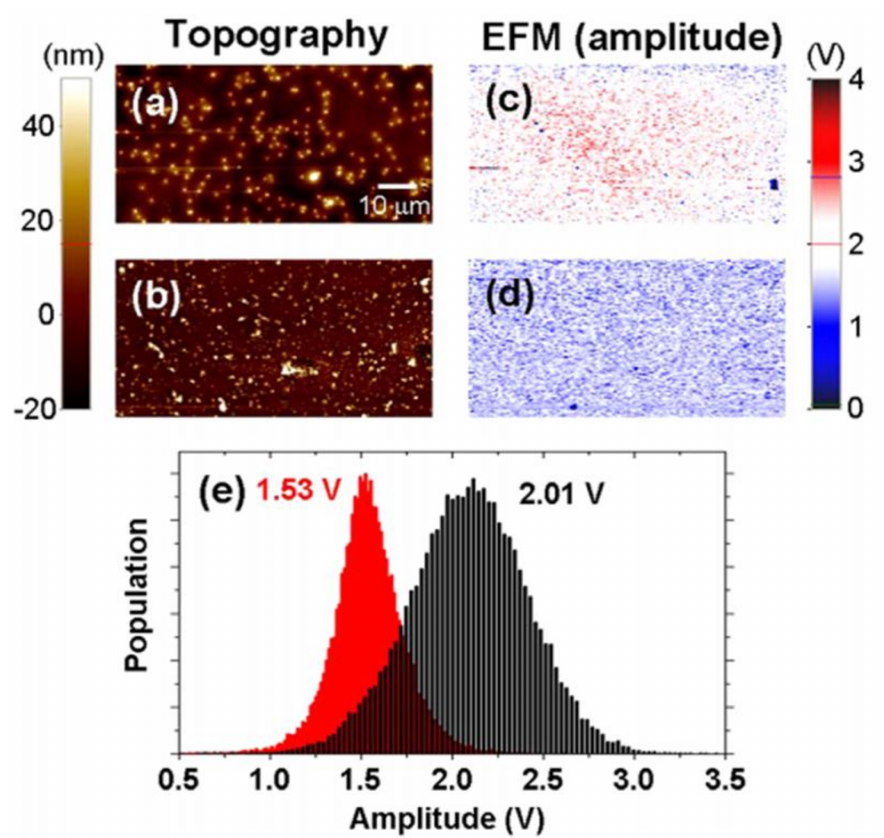
Figure 10. ( a , b ) were the topographies of the plain PET substrates. Nanoscale fixtures of silicone adhesive showed a uniform distribution. ( c , d ) were the corresponding EFM amplitude images of ( a , b ), respectively. ( a ) exhibited higher tapping amplitude (less electrostatic attractive) distribution than the ( b ). The distribution of tapping amplitude which is caused due to the electrostatic force between bare PET substrate and Au-coated AFM tip was shown in ( e ). Reprinted with permission from ref.